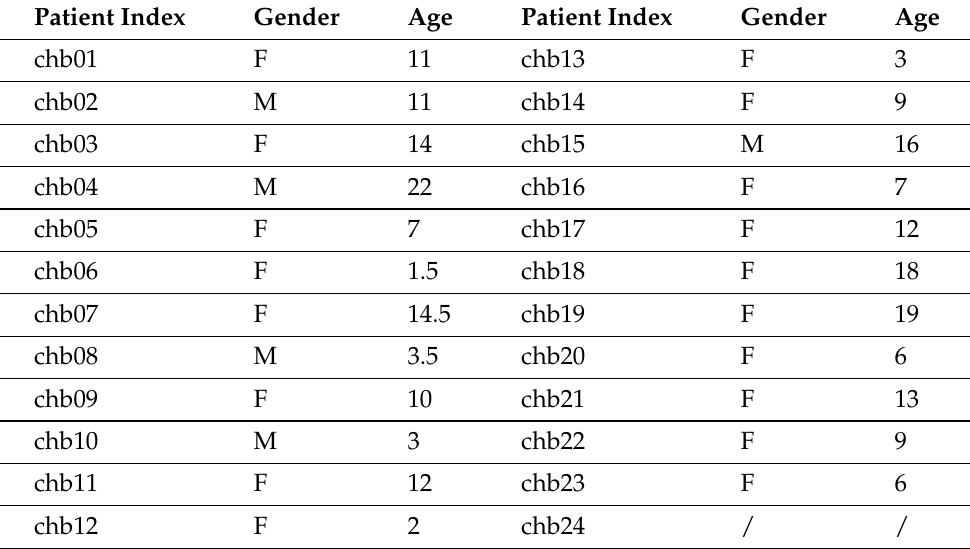
Table 7. Gender and age of the data utilized.